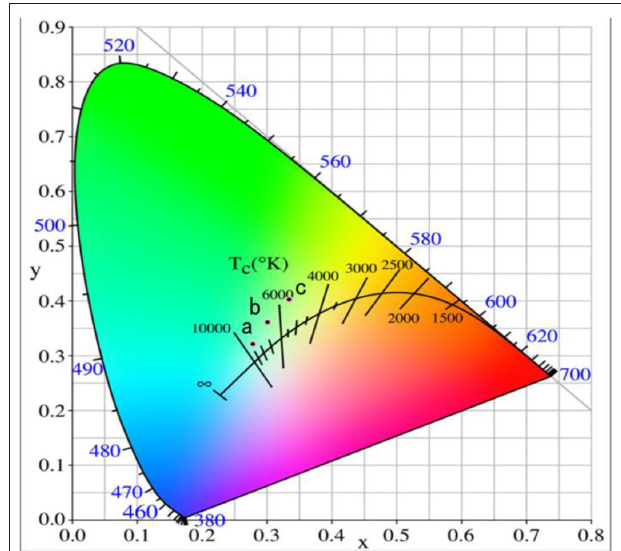
FIGURE 3 | Chromaticity coordinate of the GdAlO 3 : x%Er 3 + , 10%Yb 3 + , 1%Tm 3 + phosphors under 980nm excitation (a: x = 0.4, b: x = 0.6, c: x = 0.8).